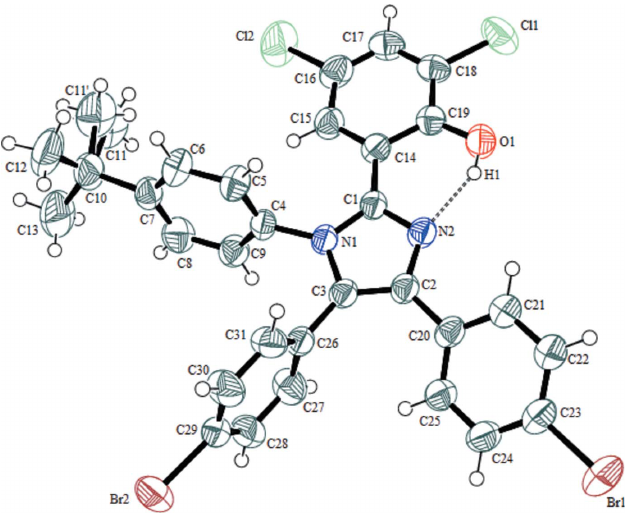
Figure 1 The molecular structure of the title compound with displacement ellipsoids drawn at the 50% probability